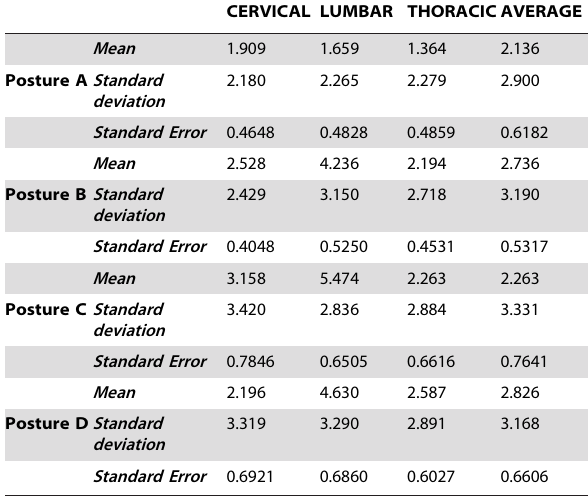
Table 3. Summary of the relationship between body pain (average of cervical, thoracic and lumbar areas for each type) and posture